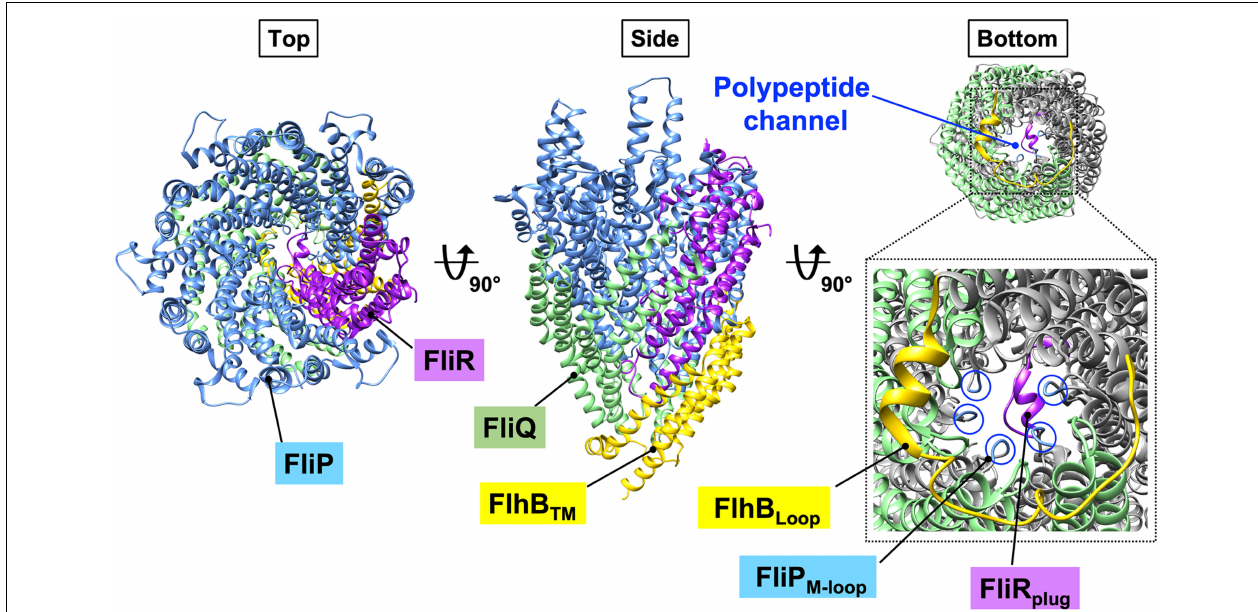
FIGURE 3 | CryoEM structure of the FlhB 1 -FliP 5 -FliQ 4 -FliR 1 complex (PDB ID: 6S3L). FliP and FliR assemble into the FliP 5 -FliR 1 complex with the help of the flagellum-specific transmembrane protein, FliO. Four copies of FliQ associates with the outside of the FliP 5 -FliR 1 complex. The central pore of the FliP 5 -FliR 1 complex is thought to be a polypeptide channel. The FliP 5 -FliQ 4 -FliR 1 complex adopts a right-handed helix similar to that of the flagellar axial structure. The transmembrane domain of FlhB (FlhB TM ) associates with the FliP 5 -FliQ 4 -FliR 1 complex. The highly conserved M-loop formed by Met-209, Met-210, and Met-211 of FliP (FliP M − loop ) and the plug loop composed of residues 106–122 of FliR (FliR plug ) block leakage of any small molecules during protein translocation. The cytoplasmic loop of FlhB FlhB Loop ) interacts with all four FliQ subunits. Because the entrance gate of the FlhB 1 -FliP 5 -FliQ 4 -FliR 1 complex is closed, FlhB is proposed to regulate opening of the gate to the polypeptide channel. Cyan, FliP; green, FliQ; magenta, FliR; yellow, FlhB TM